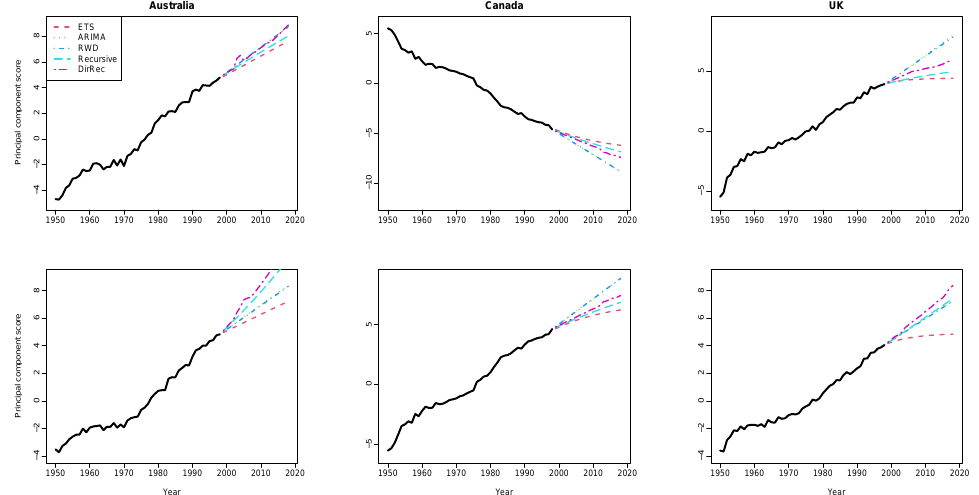
Figure 6. Computed principal component scores (solid black lines) for the first functional principal component and their 20-step-ahead forecasts (colored lines). The principal component scores and their forecasts are obtained from the log mortality datasets (female-first row and male-second row) of Australia ( left panel ), Canada ( middle panel ), and UK ( right panel